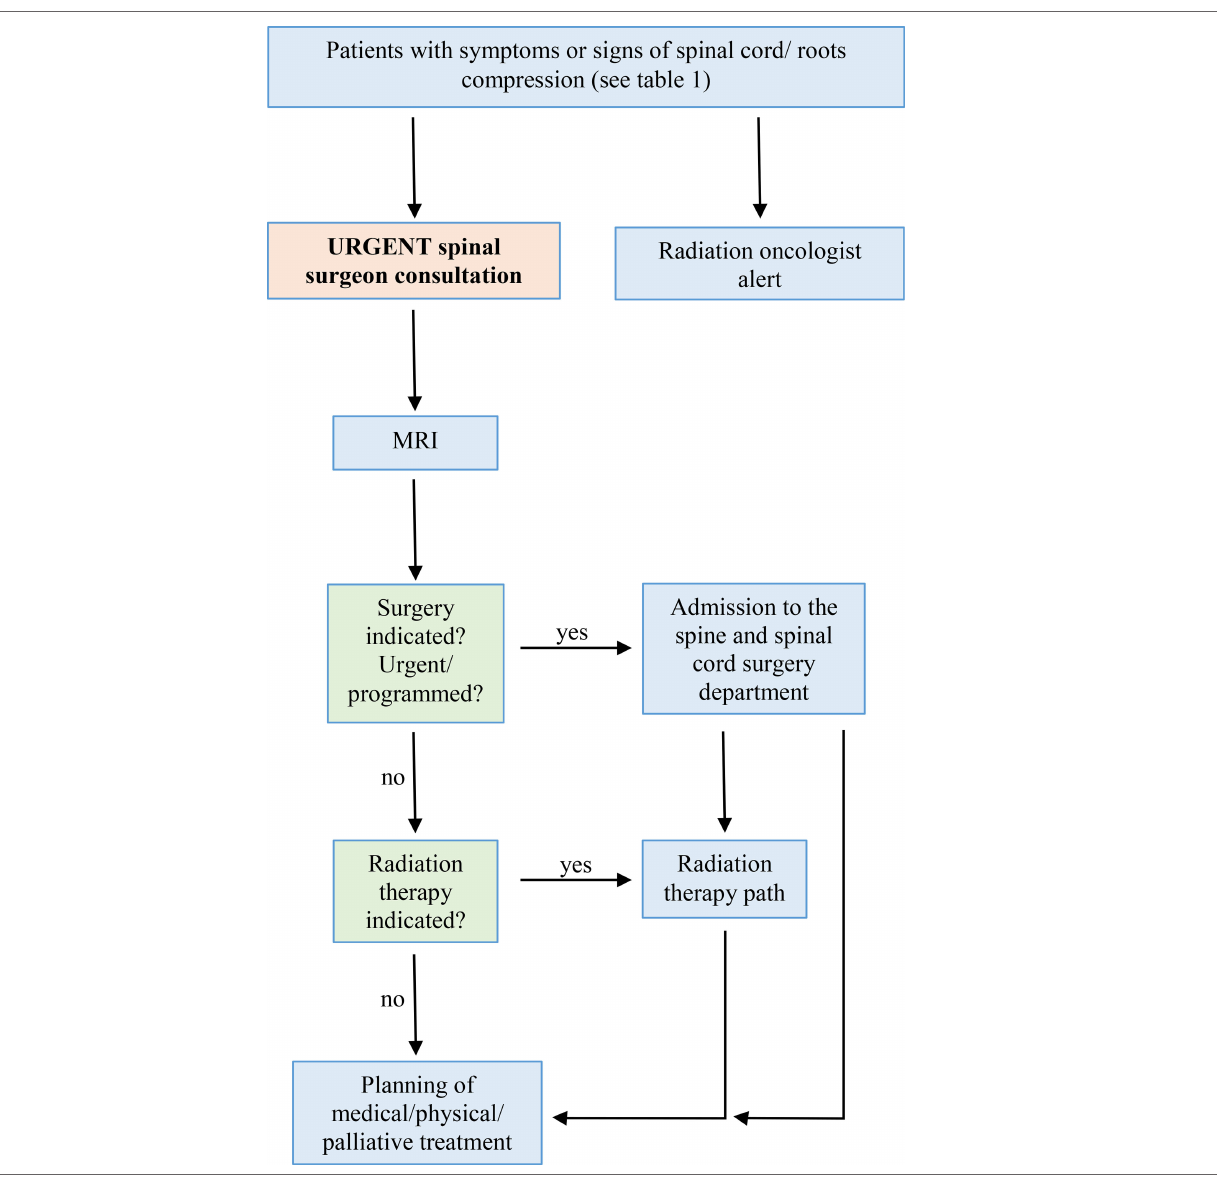
MRI, magnetic resonance